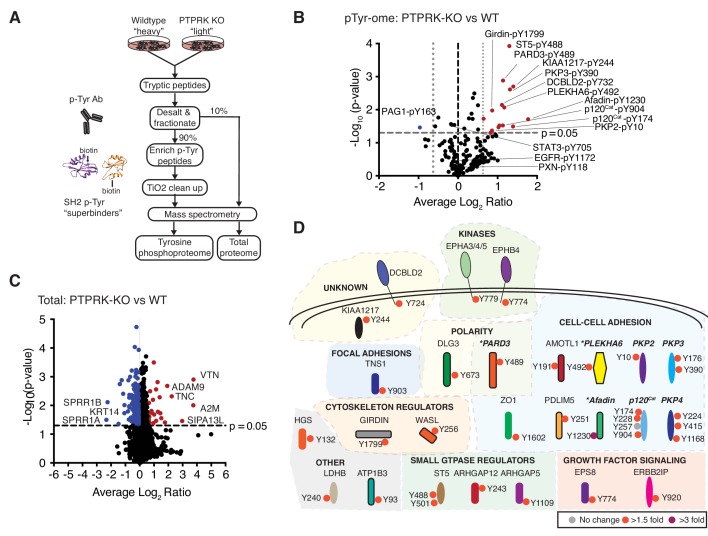
The PTPRK dependent tyrosine phosphoproteome.(A) Schematic of workflow to enrich and identify phosphotyrosine peptides from SILAC-labeled wildtype and PTPRK KO MCF10As. Equal amounts of wildtype and PTPRK KO cell lysates were combined prior to trypsinization. A 10% sample was reserved for total proteome analysis. Tyrosine phosphorylated peptides were enriched using anti-phosphotyrosine antibodies and SH2 domain ‘superbinders’. (B) Volcano plot of tyrosine phosphosites detected in PTPRK KO and wildtype MCF10As. Phosphosites > 50% enriched in (p<0.05; n = 3) in PTPRK KO cells are labeled red and those enriched in wildtype are blue. FDR = 0.01, two valid values required. (C) Volcano plot of protein abundance. Proteins > 50% more abundant (p<0.05; n = 3) in PTPRK KO MCF10As are shown in red, and wildtype in blue. FDR = 0.01, two valid values required. (D) Overview of proteins with at least one tyrosine phosphorylation site increased in PTPRK KO cells as determined by quantitative proteomics (FDR = 0.01, one valid value required). Tyrosine phosphosite change in PTPRK KO cells compared to wildtype is indicated by colored circles:>3 fold up; purple,>1.5 fold up; red,<1.5 fold up or down (no change); grey. Proteins identified as interactors by AP-MS or immunoblotting in this study are highlighted in bold and italics. *Denotes proteins enriched on substrate traps. See also Figure 3—figure supplements 1 and 2.10.7554/eLife.44597.013Figure 3—source data 1.Quantitative total and tyrosine phosphoproteomics.Spreadsheet of all raw Maxquant output files (raw) and Peruses-generated processed data (processed; requiring either 1 or two valid values) for the total and tyrosine phosphoproteomic experiments. p values were determined using a one-sample, two-sided t test performed with truncation by a Benjamini Hochberg FDR (threshold value 0.05; n = 3).10.7554/eLife.44597.014Figure 3—source data 2.Statistically upregulated proteins and phosphotyrosine sites in PTPRK KO cells following quantitative proteomics.Spreadsheet of proteins that were statistically-enriched (≥50% + p<0.05) for the total and tyrosine phosphoproteomic experiments (1 and 2 valid values). p values were determined using a one-sample, two-sided t test performed with truncation by a Benjamini Hochberg FDR (threshold value 0.05; n = 3).